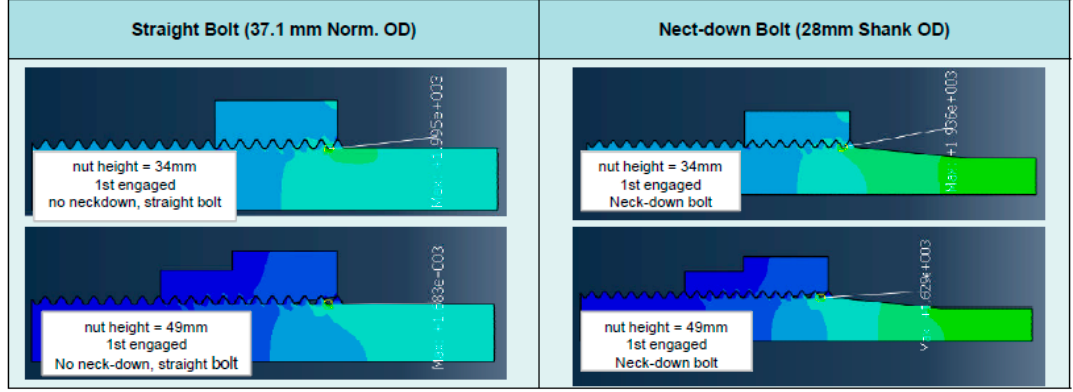
Figure 12. 2D stress analysis of straight bolt and neck-down (reduced shank) bolt.